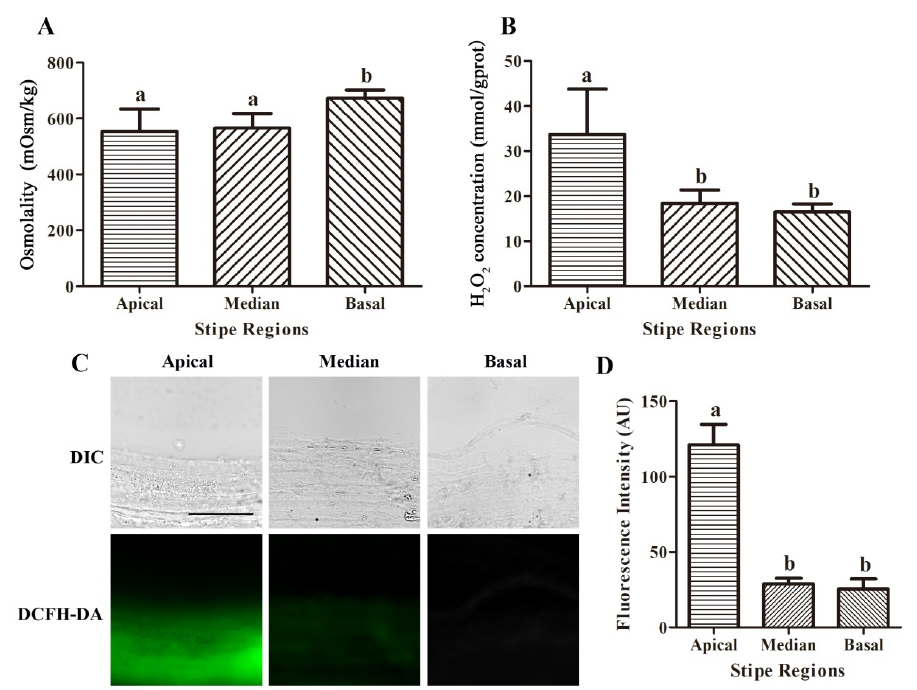
Figure 5. The osmolality ( A ) and H 2 O 2 concentration ( B ) in the fast elongating apical part, the slow elongating median part, and the nonelongating basal part of the stipe of C. cinerea . Data are presented as the mean and standard error of three biological replicates ( n = 6). The same letters indicate no significant difference ( p > 0.05), and different letters indicate significant differences ( p < 0.05) by Duncan’s test. The intracellular ROS imaging of the different regions of the stipe ( C ). The fluorescence signals of the fluorescent intracellular ROS probe DCFH-DA were observed and Bar = 50 µ m. The fluorescence intensity ( D ) was analyzed by using ImageJ 1.51 ( n = 9). The same letters indicate no significant difference ( p > 0.05), and different letters indicate significant differences ( p < 0.05) by Duncan’s